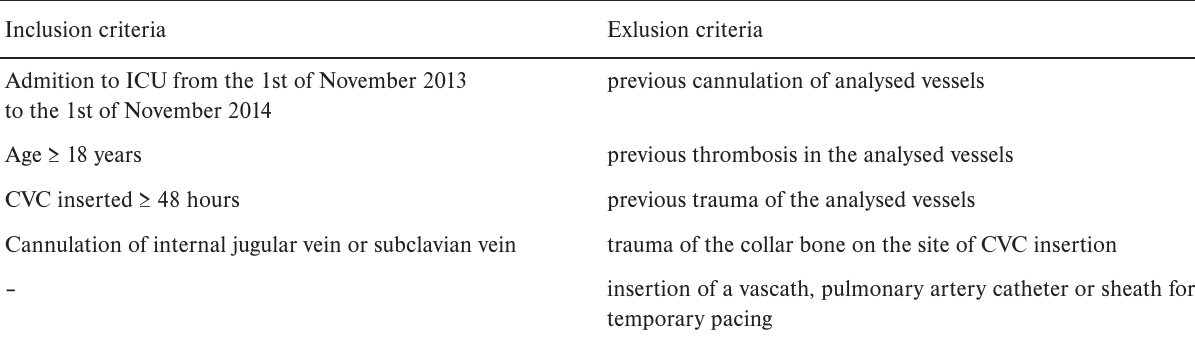
Table 1. Inclusion and exclusion criteria.